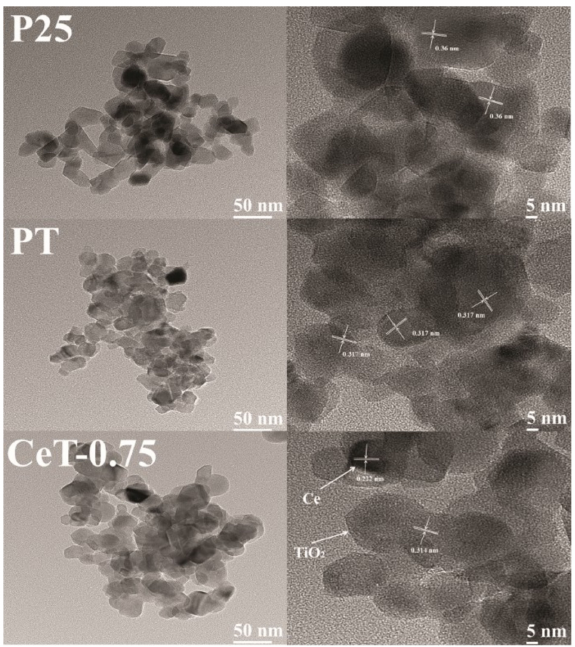
Figure 5. TEM and high-resolution TEM images of Degussa P25 TiO 2 (P25), pure TiO 2 (PT), and Ce-doped TiO 2